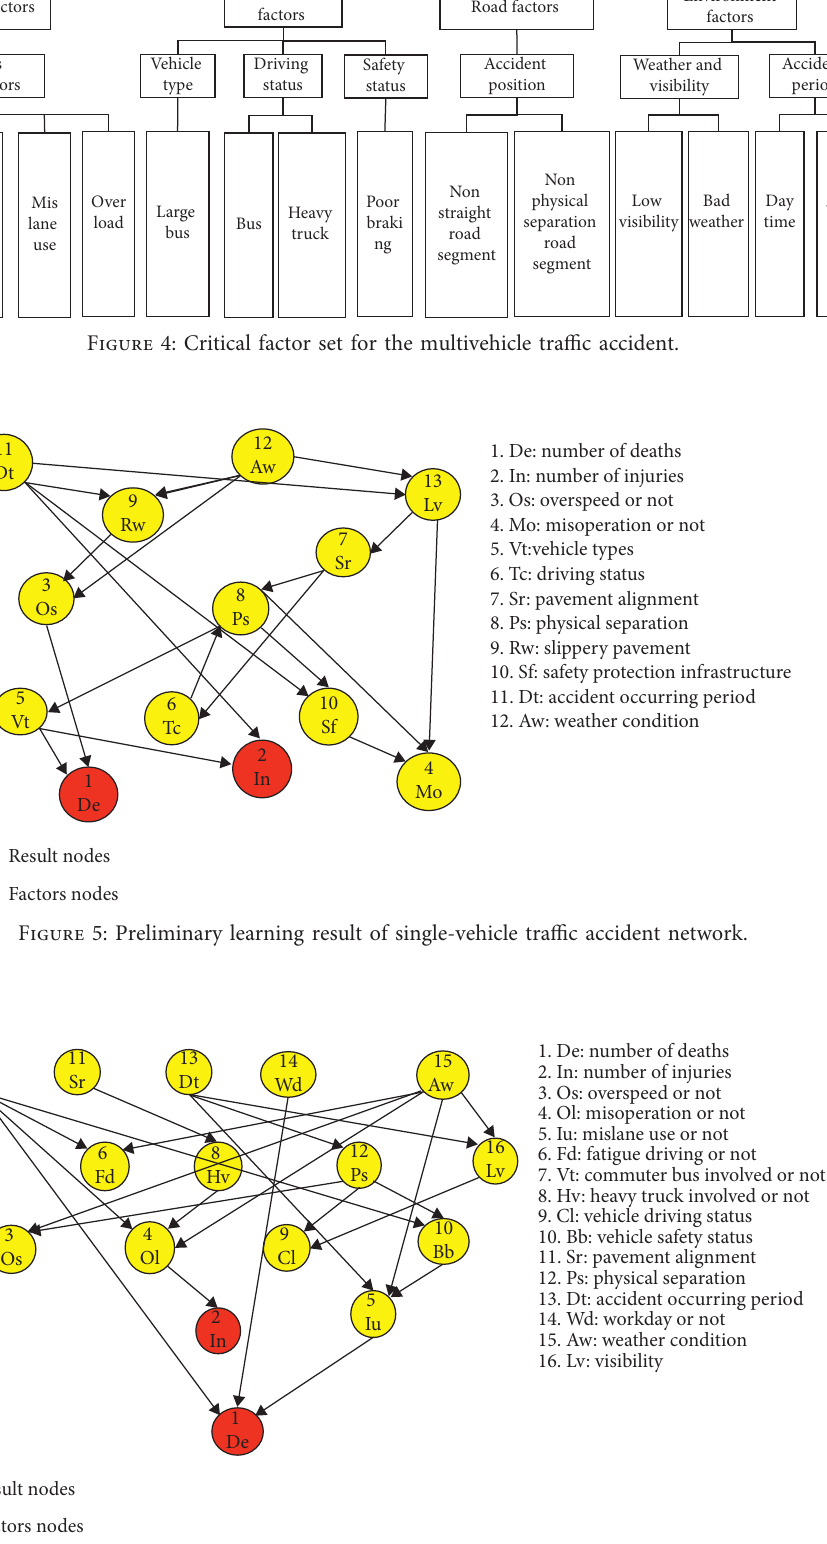
Figure 6: Preliminary learning result of multivehicle traffic accident network.